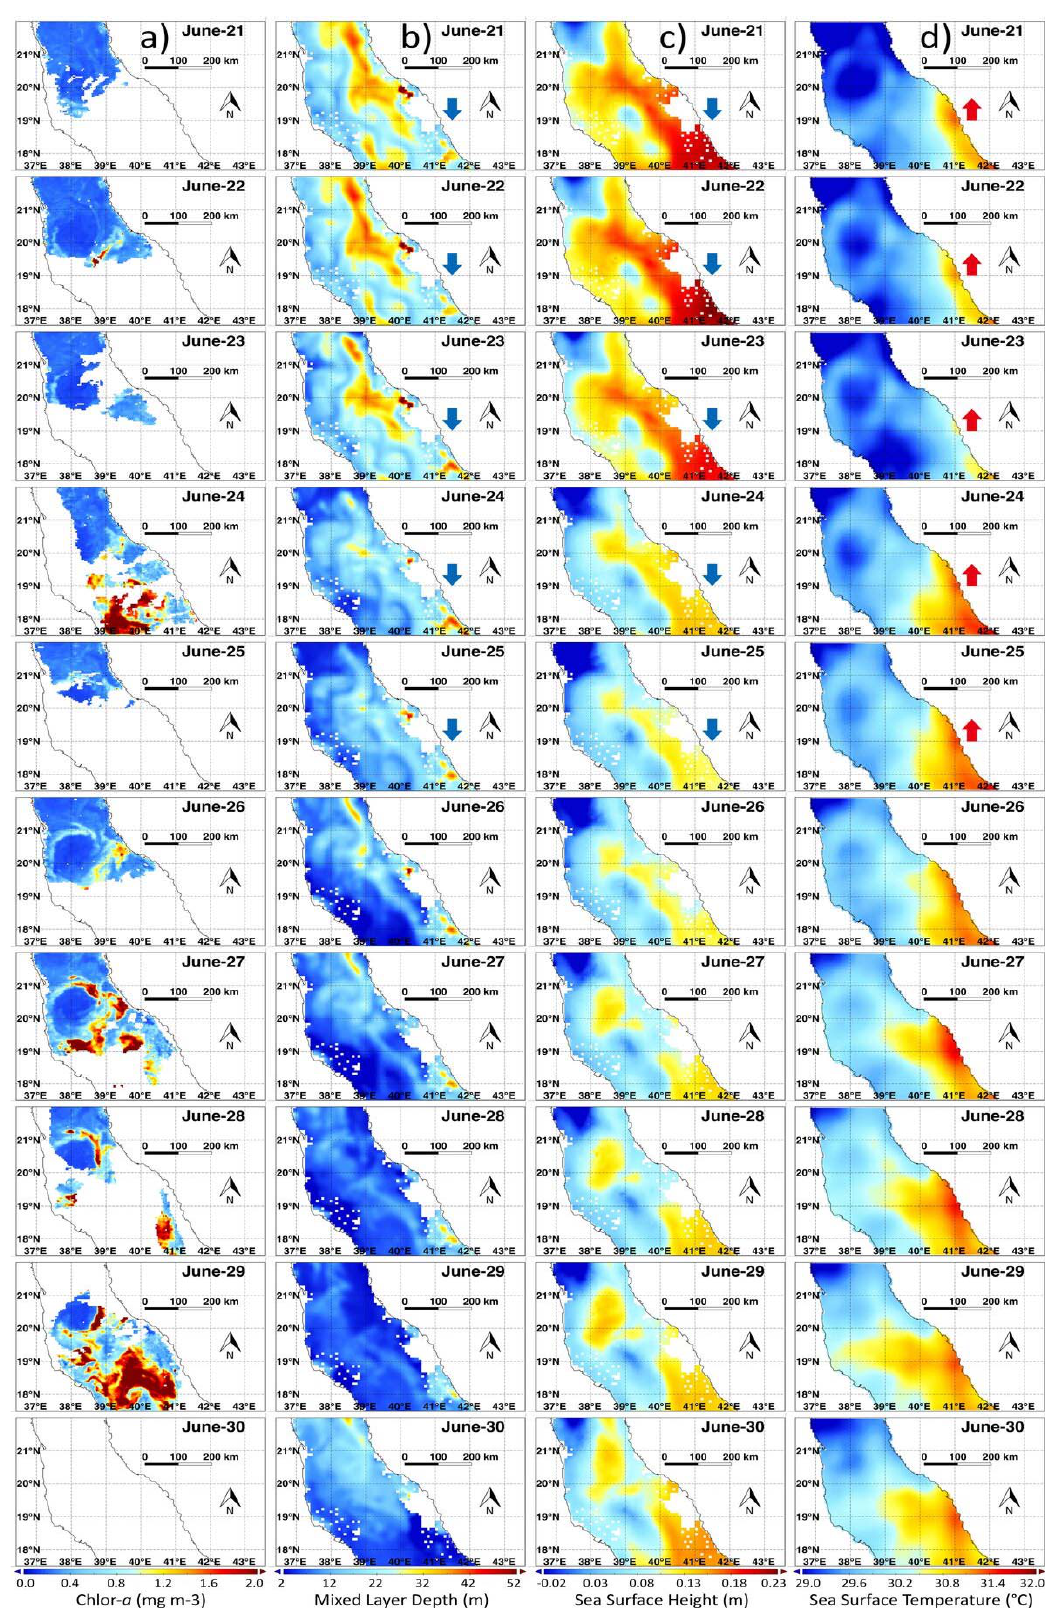
Figure 5. Daily variability from 21 June until 30 June 2015 for ( a ) Chl- a , ( b ) mixed layer depth (MLD), ( c ) sea surface height (SSH), ( d ) sea surface temperature (SST).